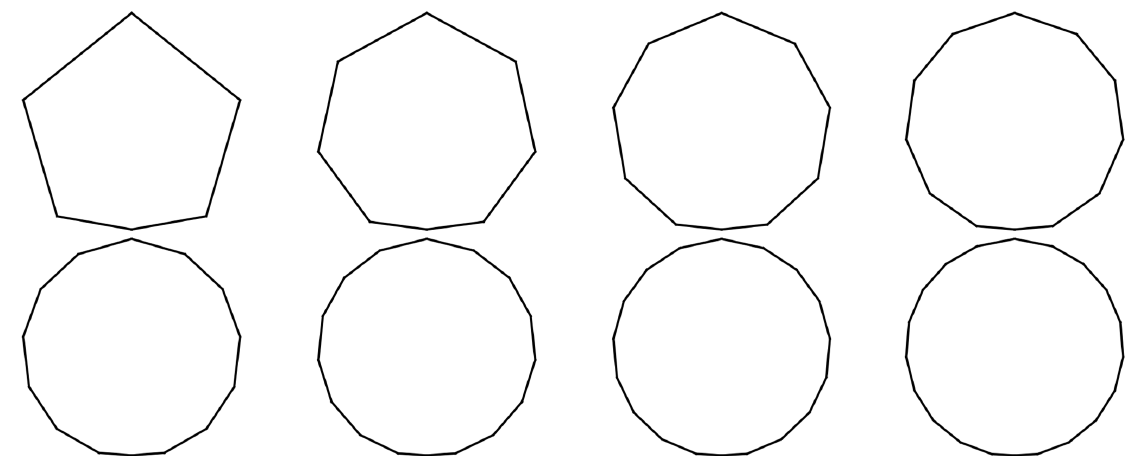
Figure 2. Conjectured largest small polygons 𝐿𝑆𝑃(𝑛) for 𝑛 = 6,8,10,12,14,16,18,20 .